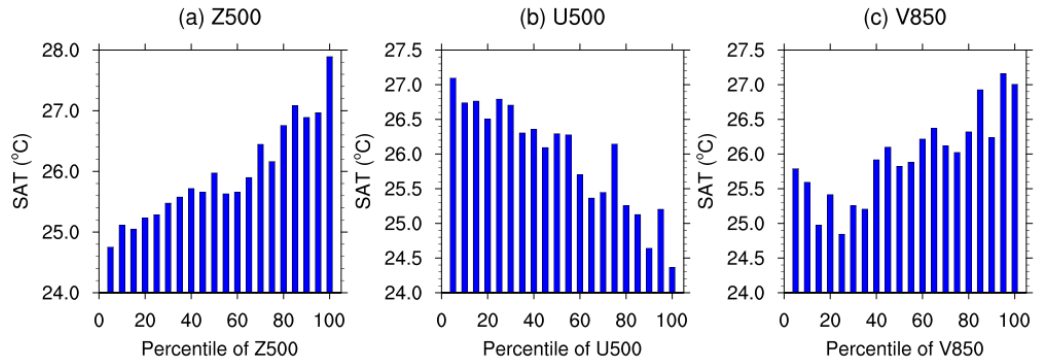
Figure 6. Relationship between SAT (°C) and climate variables: ( a ) Z500 (m), ( b ) U500 (m / s), ( c ) V850 (m / s).